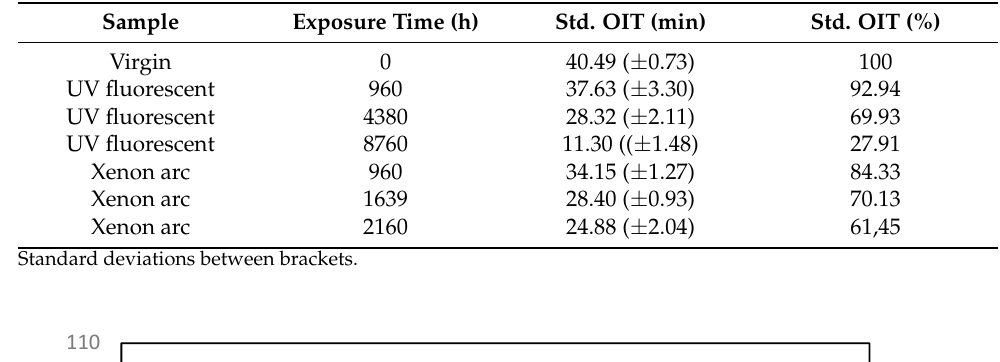
Table 4. Std. OIT test results after the UV laboratory exposures.